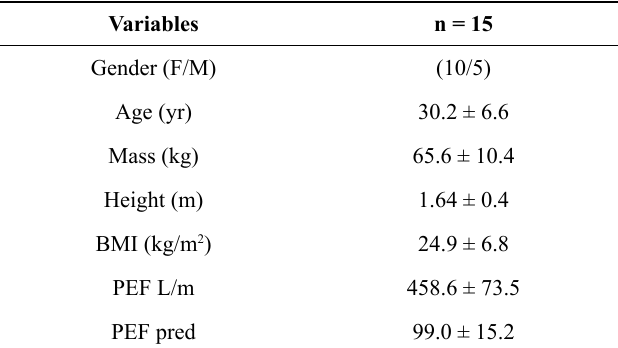
Table 1: Anthropometric characterization of participants